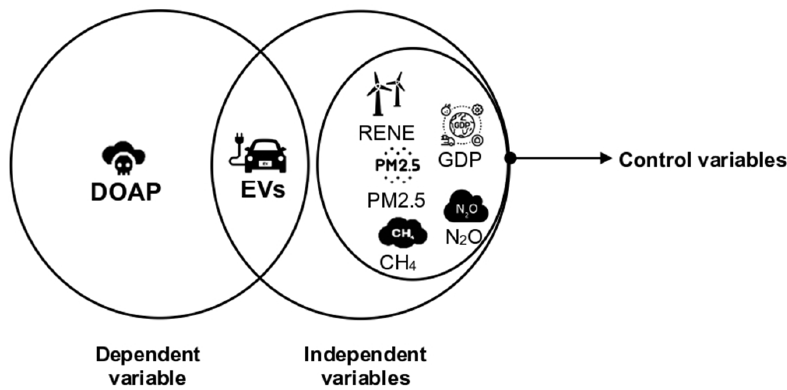
Figure 5. Venn diagram with variables of the model. The authors created this